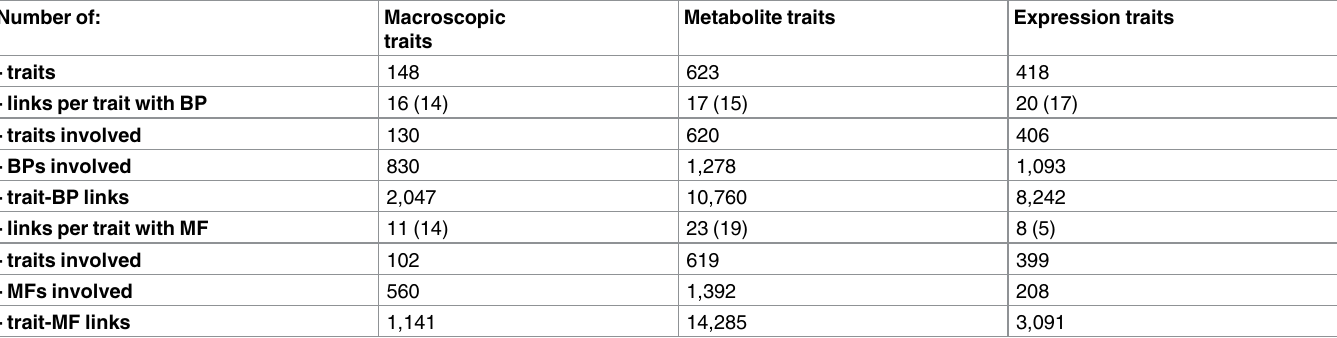
Table 2. Number of links between traits and gene function terms a .